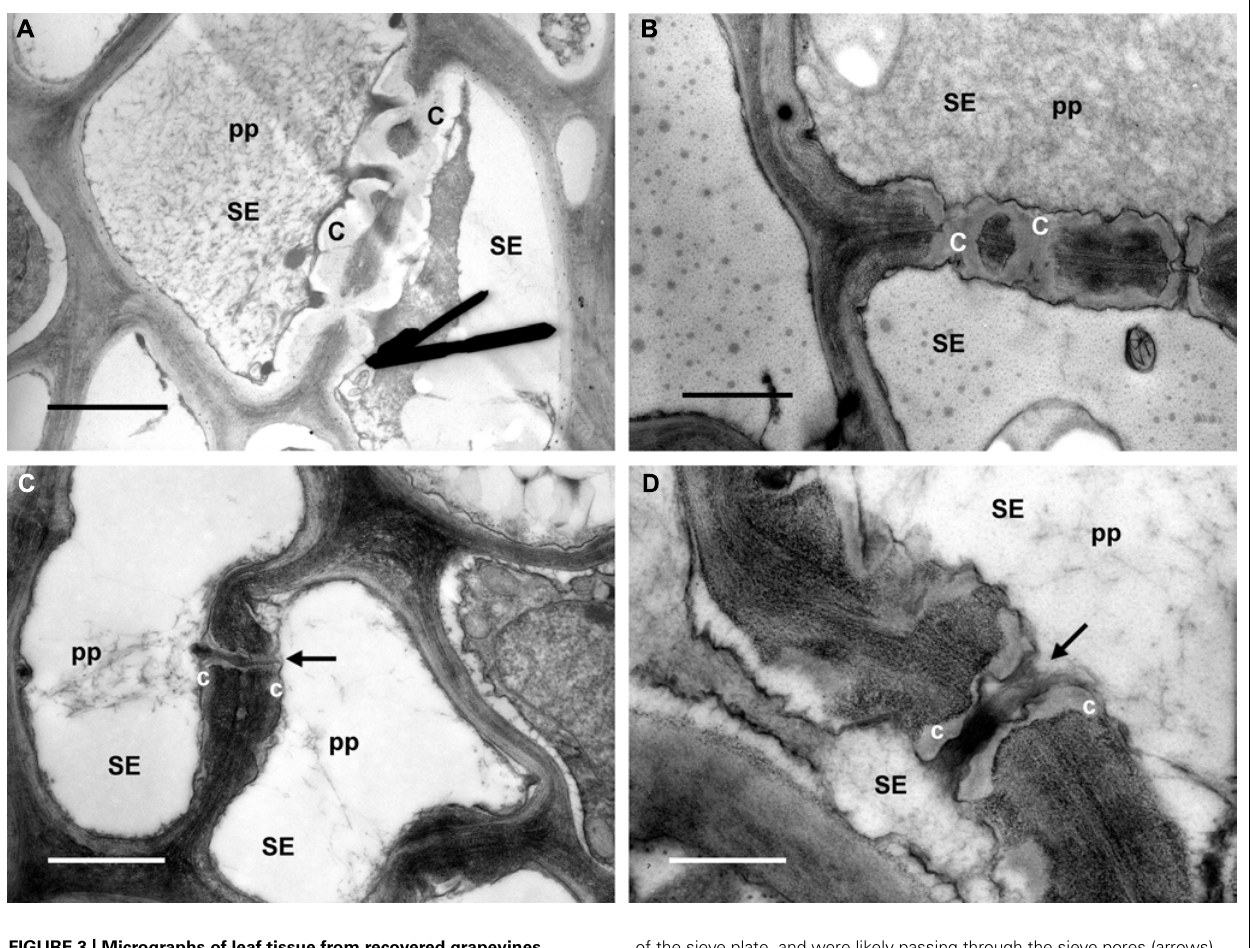
of the sieve plate, and were likely passing through the sieve pores (arrows). Note the thin callose layers (c) surrounding the sieve pores (arrows). In (A) , (B) , and (C) bars correspond to 1 μ m; in (D) bar corresponds to 0.5 μ